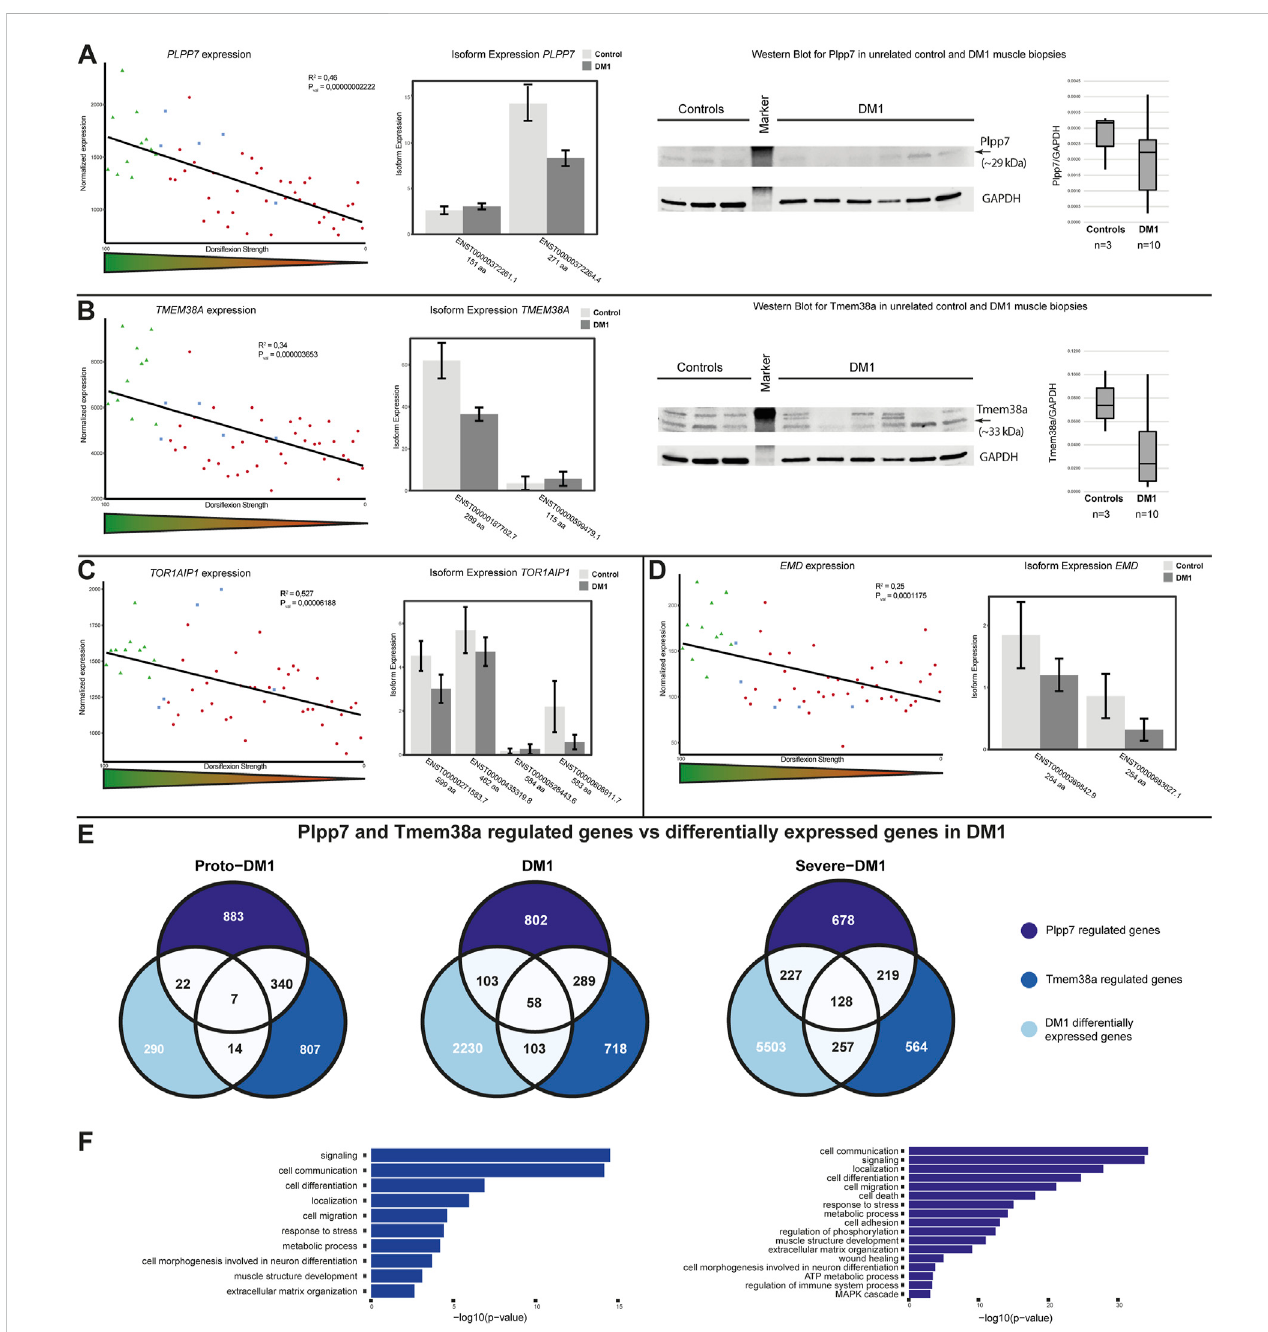
FIGURE 3 Genome organizing muscle nuclear envelope transmembrane protein (NET) expression is altered in DM1 and affects gene expression. (A) PLPP7 gene expression is correlated with dorsi fl exion strength (left panel), the main muscle isoform is downregulated (middle panel). Western blot analysis con fi rms the expressionchanges(rightpanel). (B) TMEM38A geneexpressioniscorrelatedwithdorsi fl exionstrength(leftpanel),themainmuscleisoformisdownregulated (middlepanel).Westernblotanalysiscon fi rmstheexpressionchanges(rightpanel). (C) TOR1AIP1 geneexpressioniscorrelatedwithdorsi fl exionstrength (left panel), several isoforms are downregulated (right panel). (D) EMD gene expression is correlated with dorsi fl exion strength (left panel), several isoforms only different in the UTR-region are downregulated (right panel). (E) Overlap between Plpp7 and Tmem38a regulated genes and DM1 differential expressed genes for proto-DM1, DM1, and severe DM1 based on dorsi fl exion strength. (F) GO-term enrichment for the Plpp7 and Tmem38a regulated and DM1 differential expressed